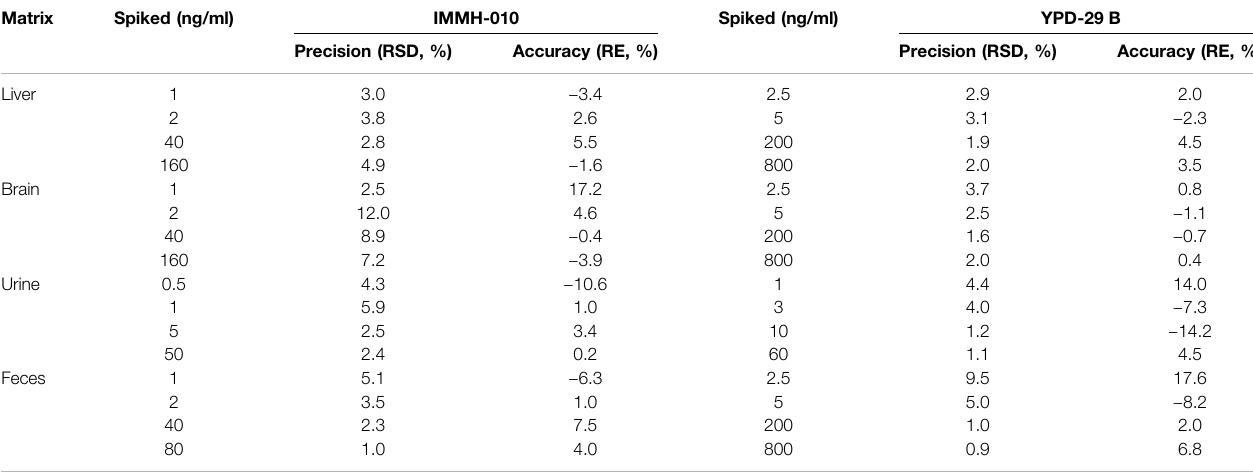
TABLE 4 | Internal standard normalization matrix factor and recovery of IMMH- 010 and YPD-29B in rat plasma ( n (cid:1) 6). Analyte Spiked (ng/ml) IS-normalized MF